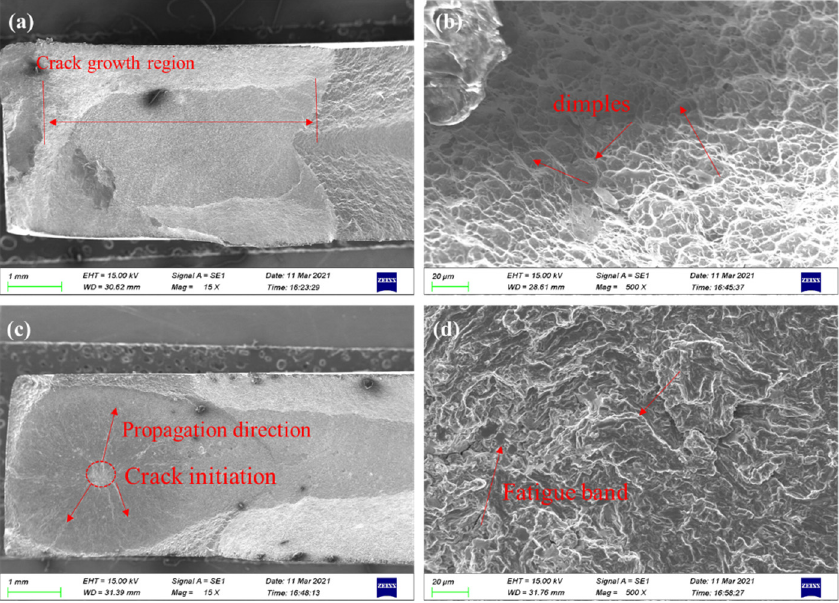
Figure 10. ( a , b ) Untreated TC6 titanium alloy and ( c , d ) LSP-treated Ti-2 samples.